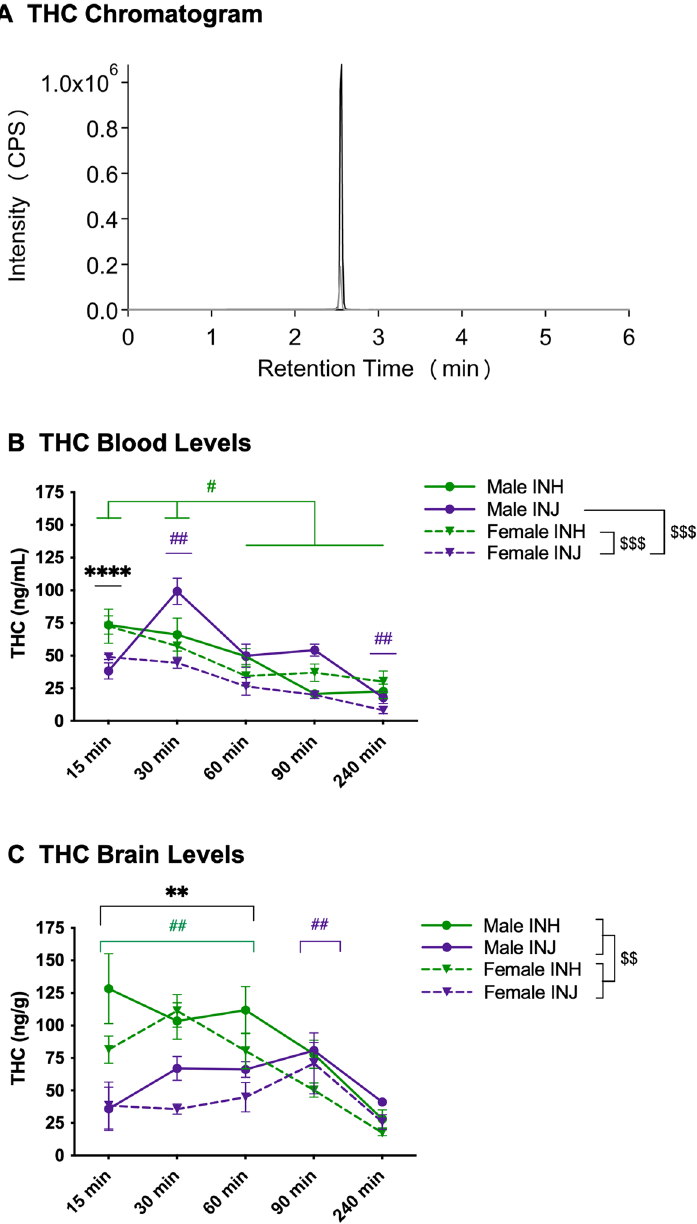
Figure 3. THC Chromatogram and levels in blood and brain. ( A ) LC-MS Chromatogram: THC (black line) and THC-d3 (grey line) overlapping peaks at 2.7 min. ( B ) Blood levels: data are presented as mean ± SEM; n = 5–6 for each group. Presence of (*) indicates an administration difference with INH > INJ at 15-min at **** p < 0.0001. Presence of ( # ) indicates a timepoint difference with green and purple lines indicating an INH and INJ difference respectively; specifically, INH-15 > all timepoints and INH-30 > INH-60/90/240 at # p < 0.05, whereas INJ-30 > all timepoints and INJ-240 < all timepoints at ## p < 0.01. Presence of ( $ ) indicates a sex difference; specifically, female-INH > female-INJ at $$$ p < 0.001 and male-INJ > female-INJ at $$$ p < 0.001). ( C ) Brain levels: data are presented as mean ± SEM; n = 5–6 for each group. Presence of (*) indicates an administration difference with INH > INJ at 15, 30, and 60-min at ** p < 0.01. Presence of ( # ) indicates a timepoint difference with green and purple lines indicating an INH and INJ difference respectively; specifically, INH-15, 30, and 60 > INH-90 and 240 at ## p < 0.01, whereas INJ-90 > INJ-15 and 240 at ## p < 0.01. Presence of ( $ ) indicates a sex difference with males > females at $$ p <